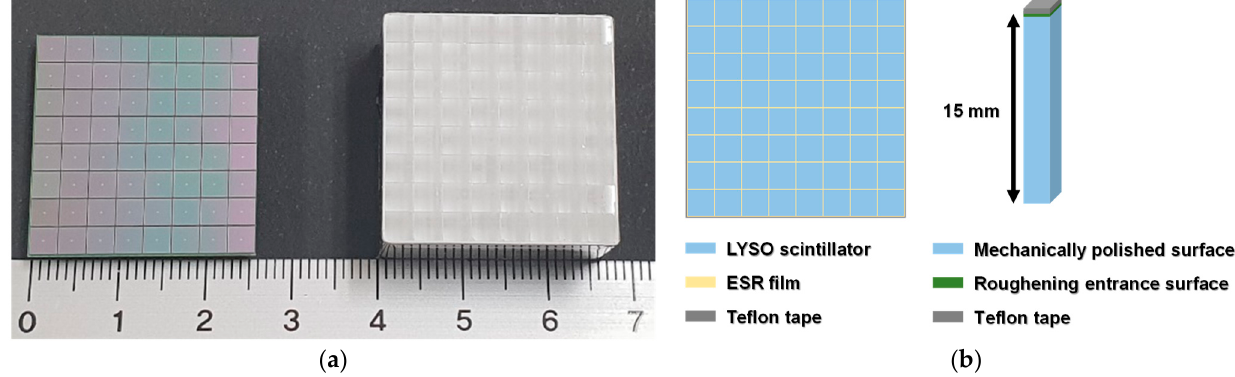
Figure 2. ( a ) 8 × 8 array of 3 × 3 mm 2 MPPCs (left) and 8 × 8 array of 3.11 × 3.11 × 15 mm 3 LYSO scintillators (right). ( b ) Design of the LYSO array considering optimal optical properties (surface treatment and reflective materials).